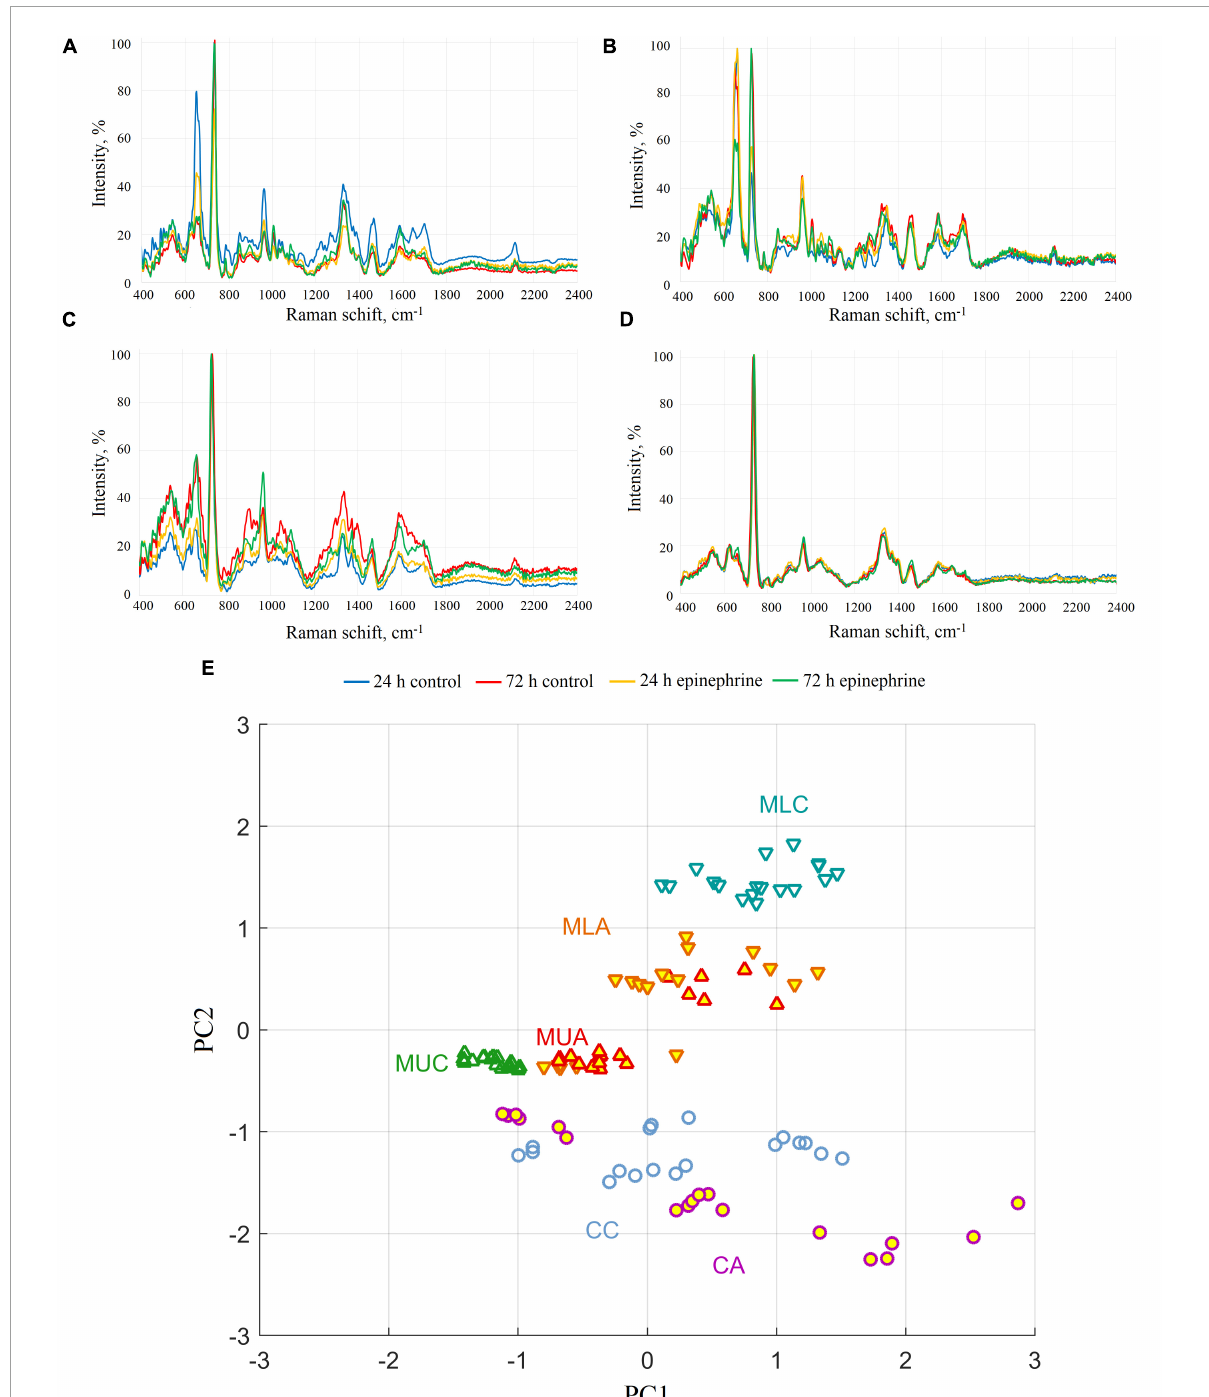
FIGURE3 SERS spectra of M. luteus C01 biofilms. (A) Upper phase of the matrix. (B) Lower phase of the matrix. (C) Intact biomass. (D) Biomass after matrix extraction. (E) Principal component analysis of SERS spectra for 72 h samples (CC, control cells; CA, epinephrine-treated cells; MUC, control upper phase of the matrix; MUA, epinephrine-treated upper phase of the matrix; MLC, control lower phase of the matrix; MLA, epinephrine-treated lower phase of the